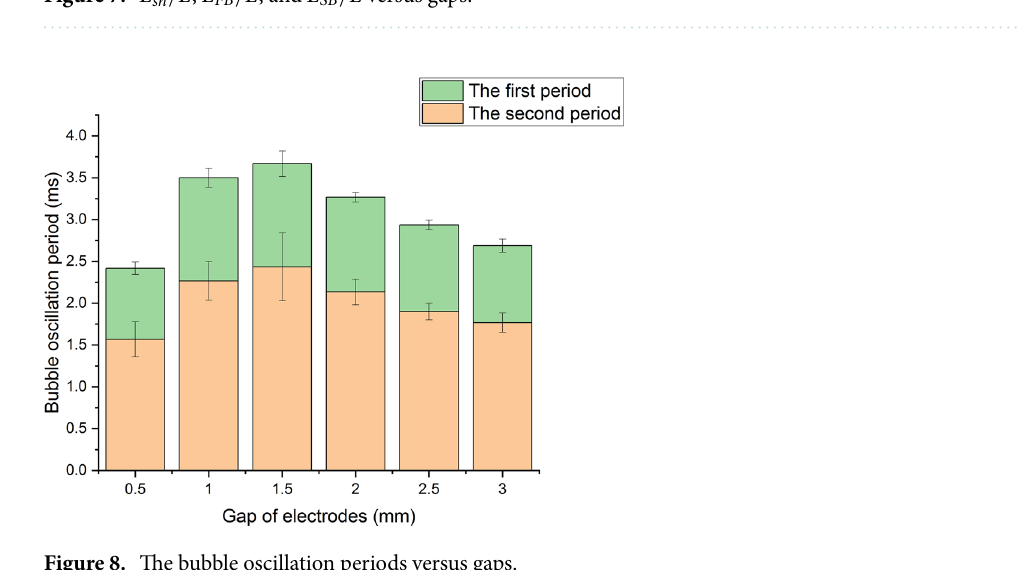
Figure 7. E sh / E , E FB / E , and E SB / E versus gaps.